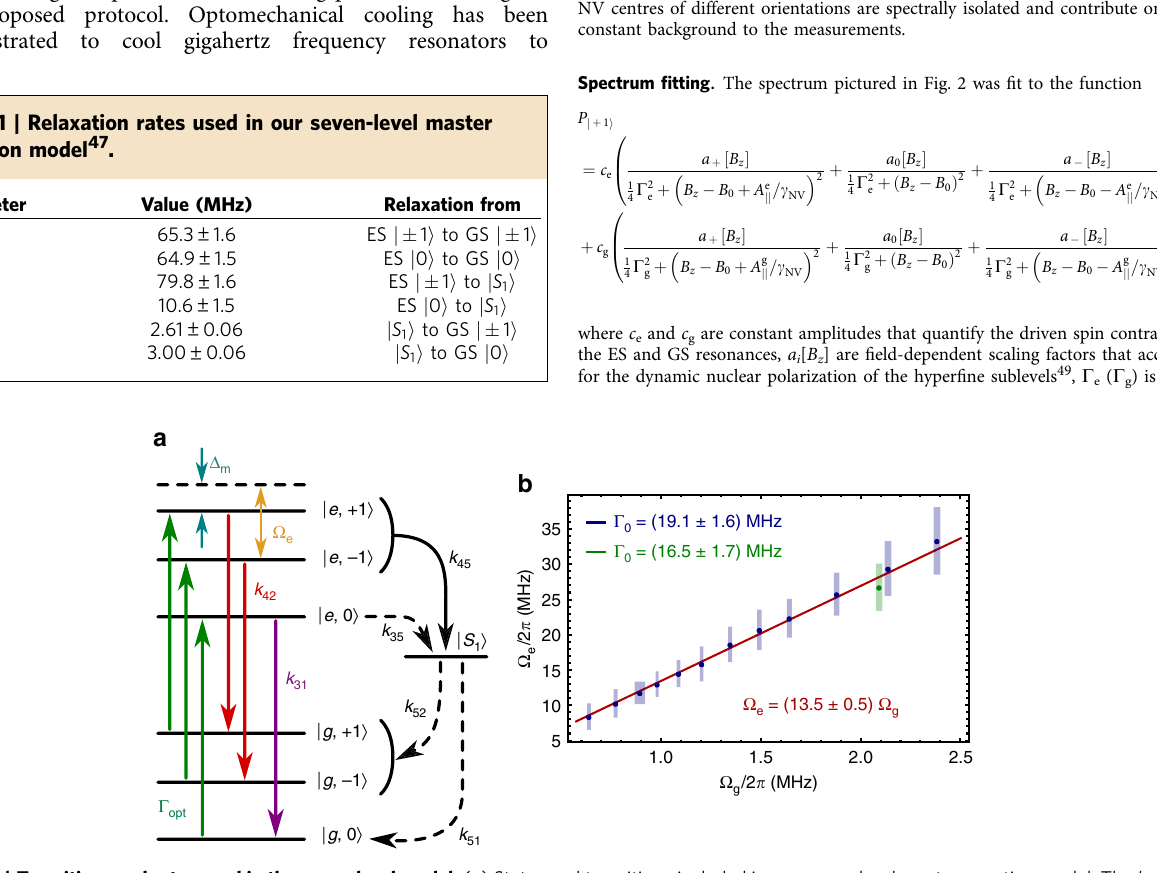
Figure 6 | Transitions and rates used in the seven-level model. ( a ) States and transitions included in our seven-level master equation model. The k ij rates are listed in Table 1. ( b ) Excited state mechanical driving field O e plotted as a function of the ground state mechanical driving field O g with the data labelled by the optical pumping rate G 0 during each measurement. Each point corresponds to a single measurement, and error bars are standard error from the